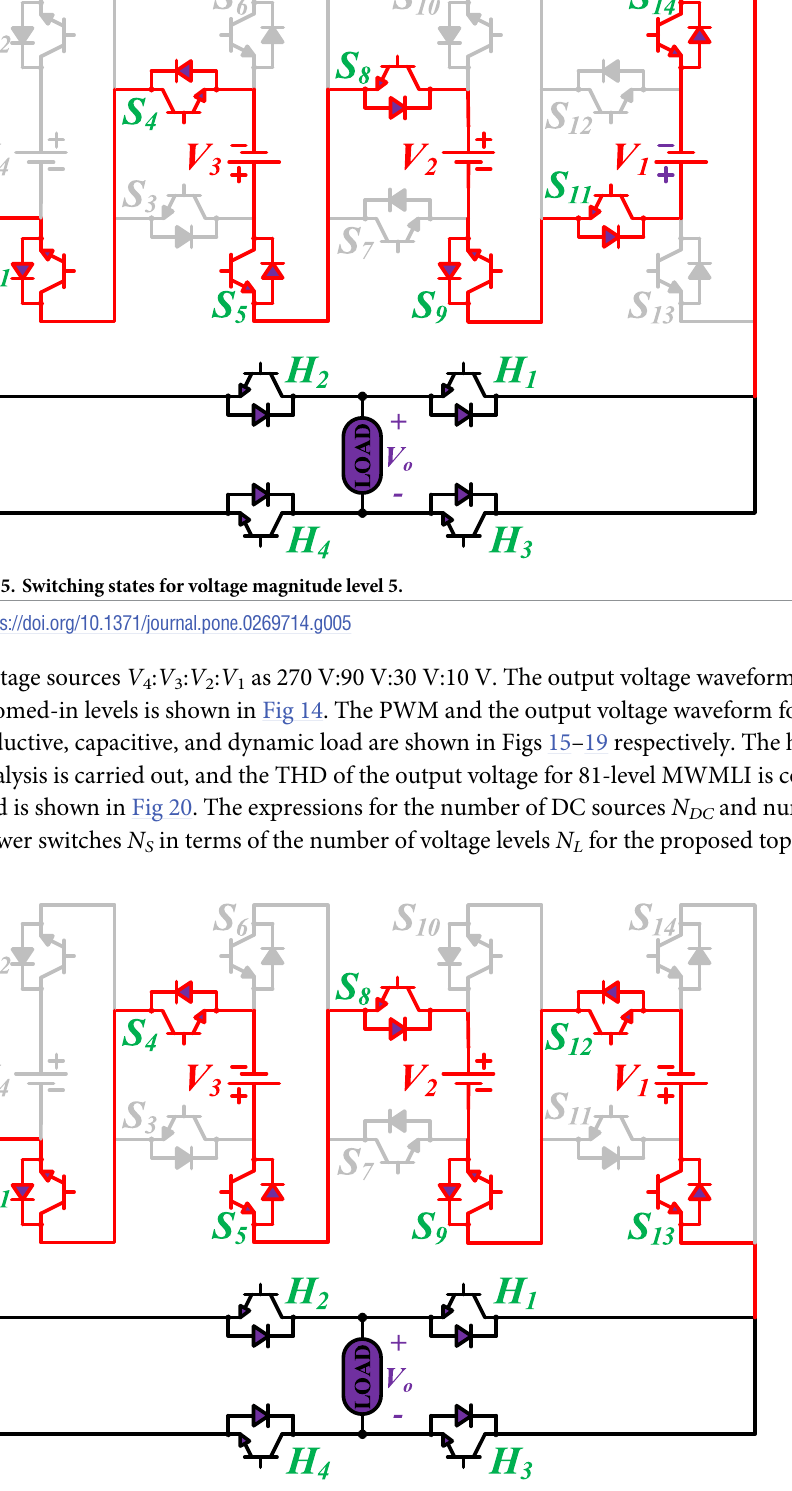
Fig 6. Switching states for voltage magnitude level